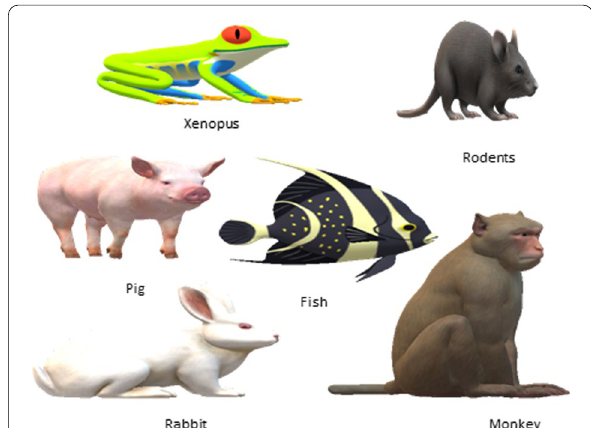
Fig. 2 Various animal models used for research and therapeutic studies: Xenopus, rodent, rabbit, and fish mostly preferred because of their small size, easy maintenance in laboratories, small gestation period, and a high number of live young. Genetic similarity between these organisms and humans makes them a preferable choice as human disease models. Pig and Monkey are used in research due to their organ size, and structure. The development of new genome modification tools resulted in regaining the interest of researchers towards large size non-rodent and non-human